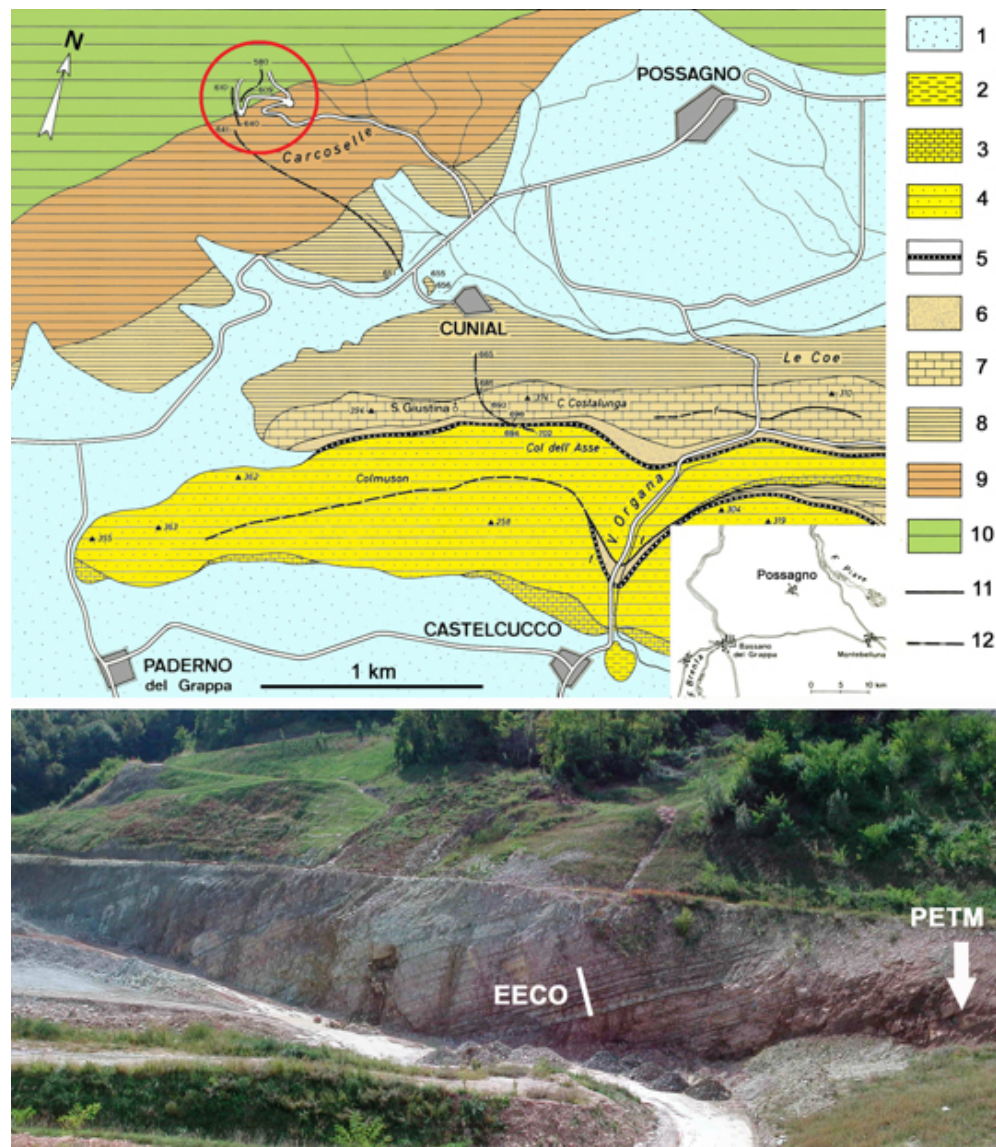
Figure 3. The Possagno section. Upper panel: geological map (modified from Braga, 1970). 1: Quaternary deposits; 2, 3: Calcarenite di Castelcucco (Miocene); 4: glauconitic arenites (Miocene); 5: siltstones and conglomerates (upper Oligocene–lower Miocene); 6: Upper Marna di Possagno (upper Eocene); 7: Formazione di Pradelgiglio (upper Eocene); 8: Marna di Possagno (upper Eocene); 9: Scaglia Cinerea (middle–upper Eocene); 10: Scaglia Rossa (Upper Cretaceous–lower Eocene); 11: faults; 12: traces of stratigraphic sections originally studied by Bolli (1975); red circle: the Carcoselle quarry. Lower panel: the exposed quarry face during Summer 2002 (Photo by Luca